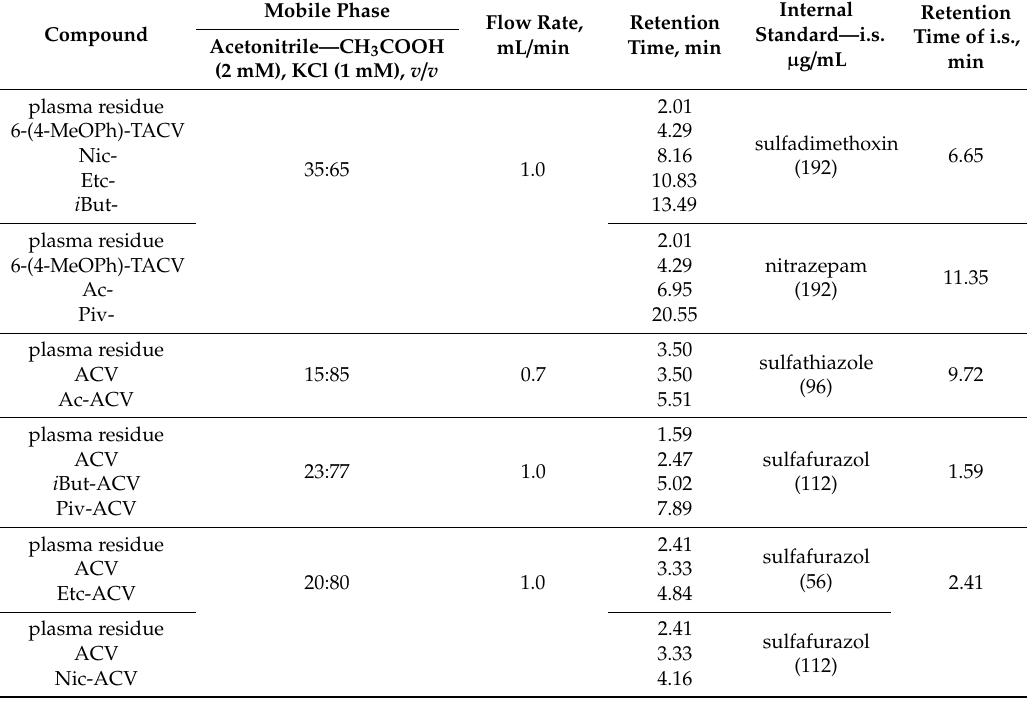
Table 1. Conditions for chromatographic separation of the HPLC-UV method and retention times of the tested